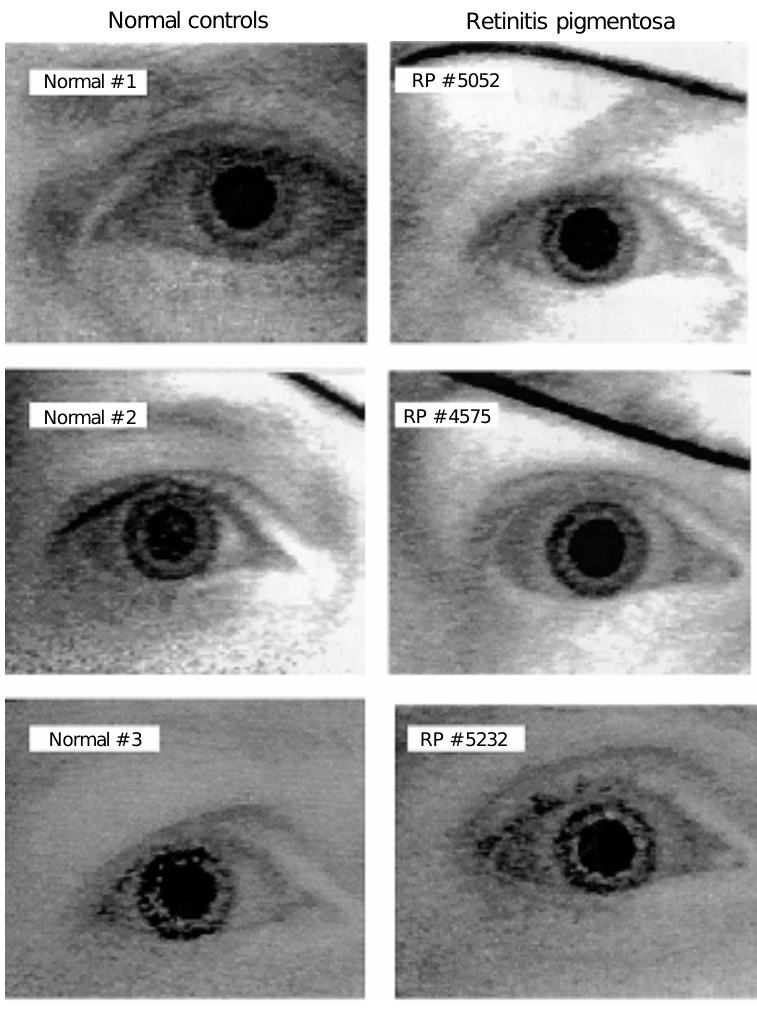
Figure 1. Representative pupil images from three normal subjects and three patients with retinitis pigmentosa (RP). Images were obtained with infrared illumination following 45 min of